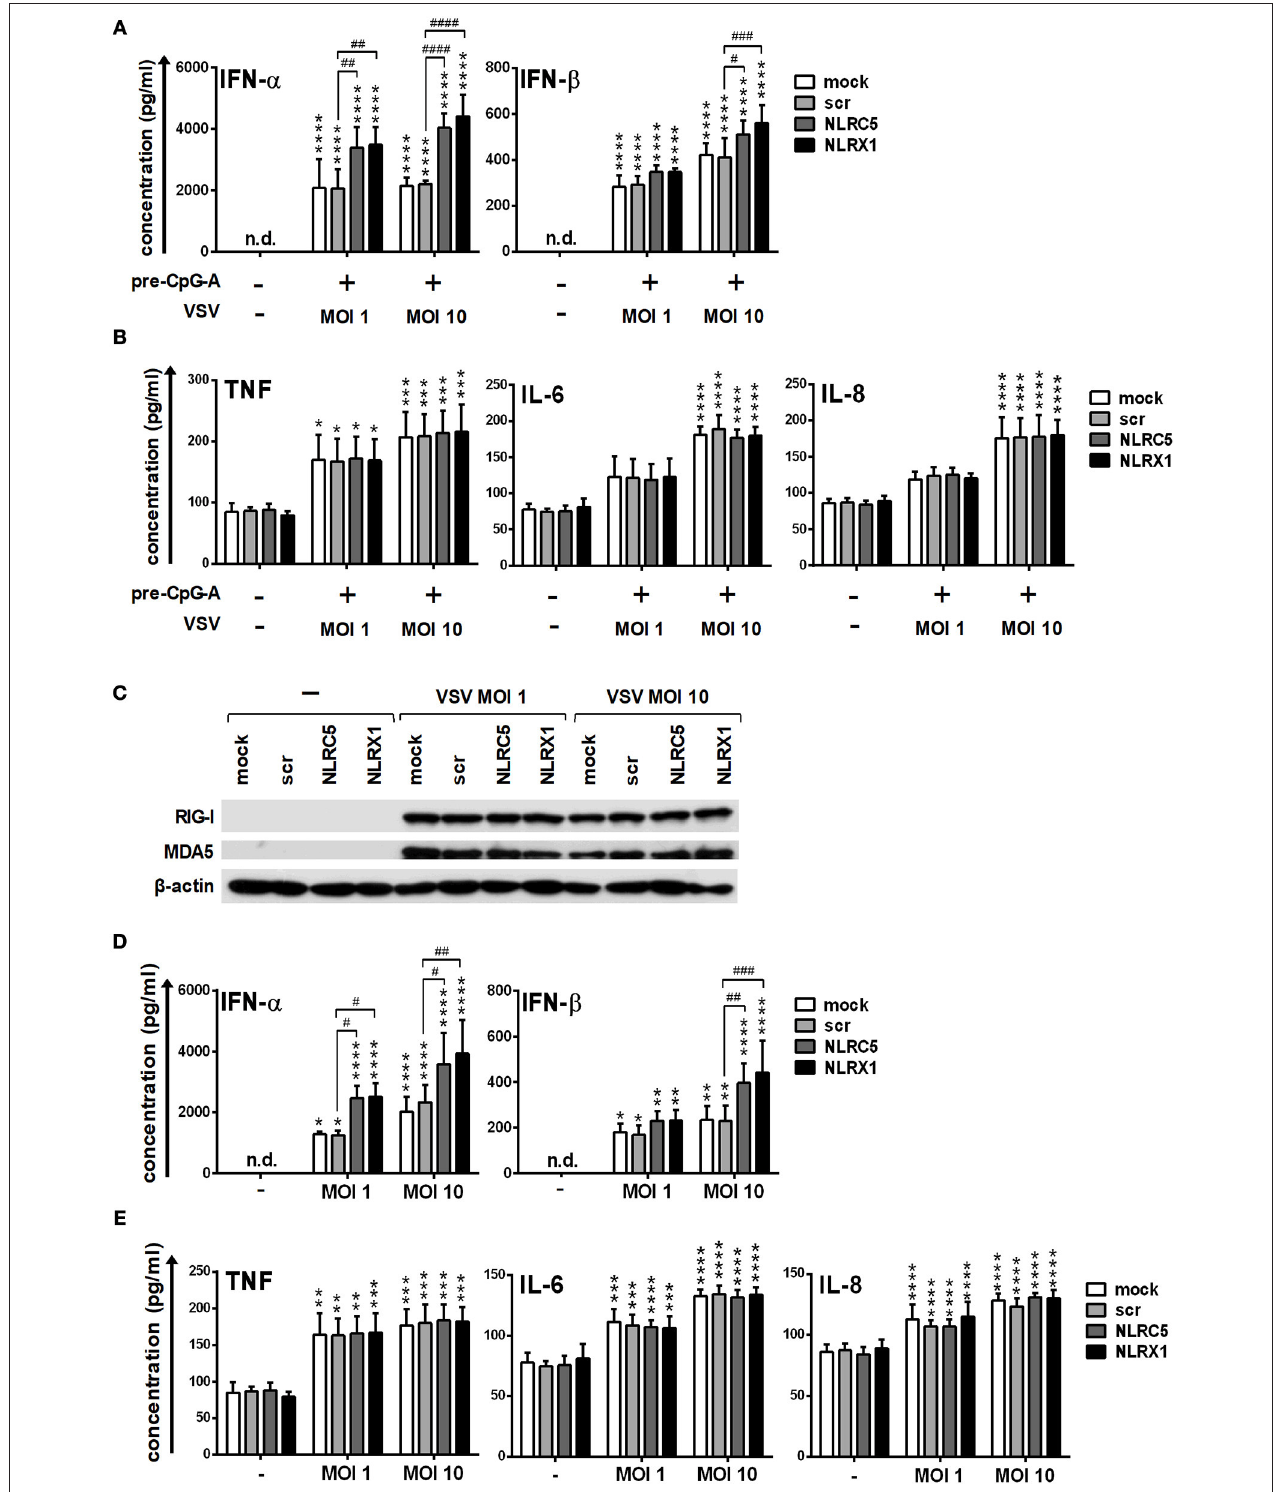
FIGURE 9 | Depletion of NLRC5 or NLRX1 enhances the type I IFN production of GEN2.2 cells but does not influence the NF- κ B pathway activity in response to VSV infection. (A–E) Cells were transfected with siRNAs specific for NLRC5, NLRX1 or scrambled (scr) siRNAs for 24h. (A,B) After silencing cells were pre-treated with